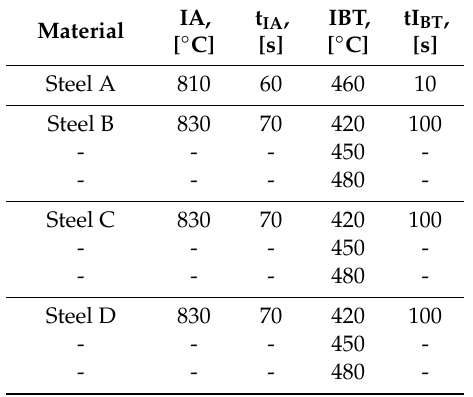
Table 3. Intercritical annealing temperature (IA), annealing time t IA , isothermal bainitic transformation temperature (IBT), and holding time t IBT for the